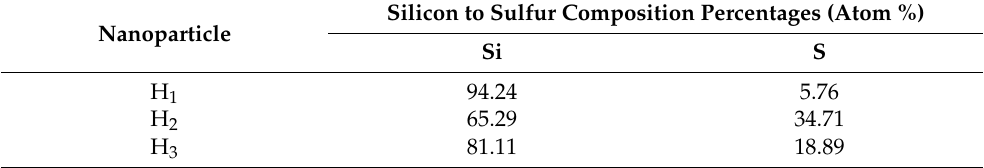
Table 2. Percentages of atomic concentration of silicon and sulfur in layer-by-layer HMSNPs mea- sured by EDS.